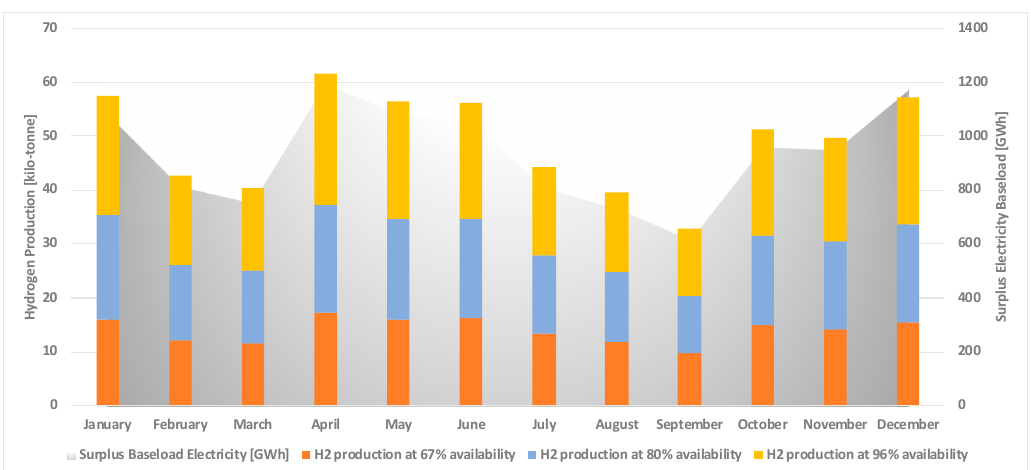
Figure 5. The monthly trends of Ontario’s surplus baseload electricity and the electrolytic hydrogen production at the three different capacity factors.